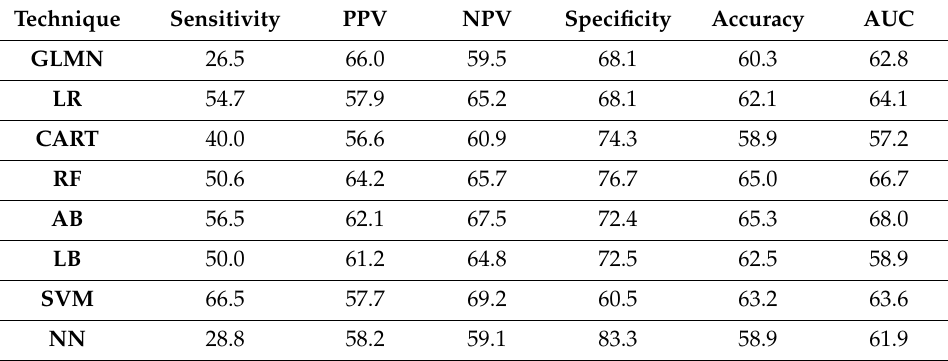
Table 3. Performance of GLMN, LR, CART, RF, AB, LB, SVM, and NN obtained with M-I analysis. The values represent sensitivity, positive predictive value (PPV), negative predictive value (NPV), specificity and accuracy averaged over the values obtained on each